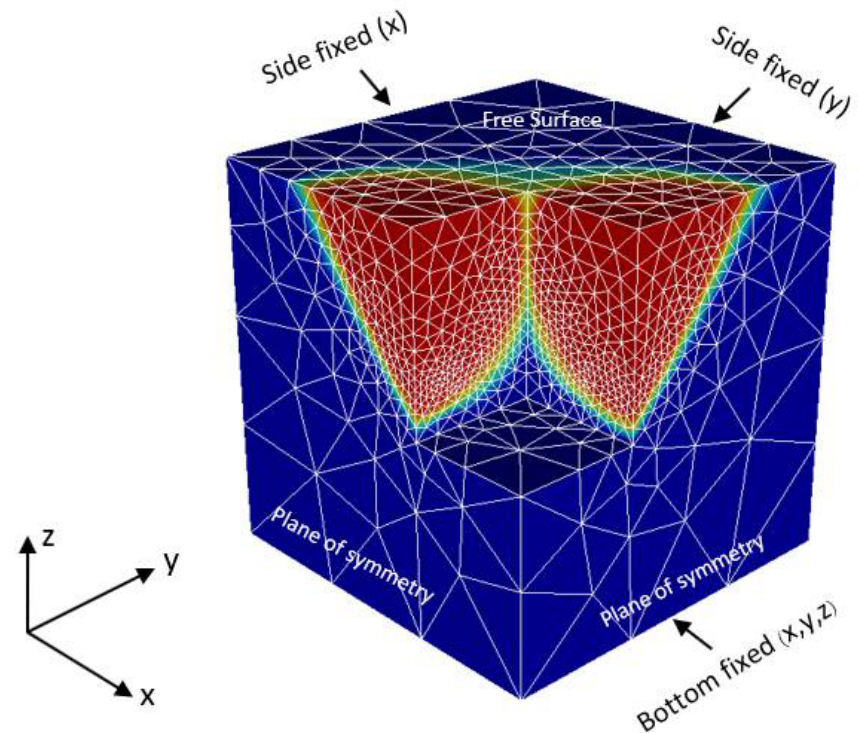
Figure 3. A typical FELA model and potential failure mechanism.